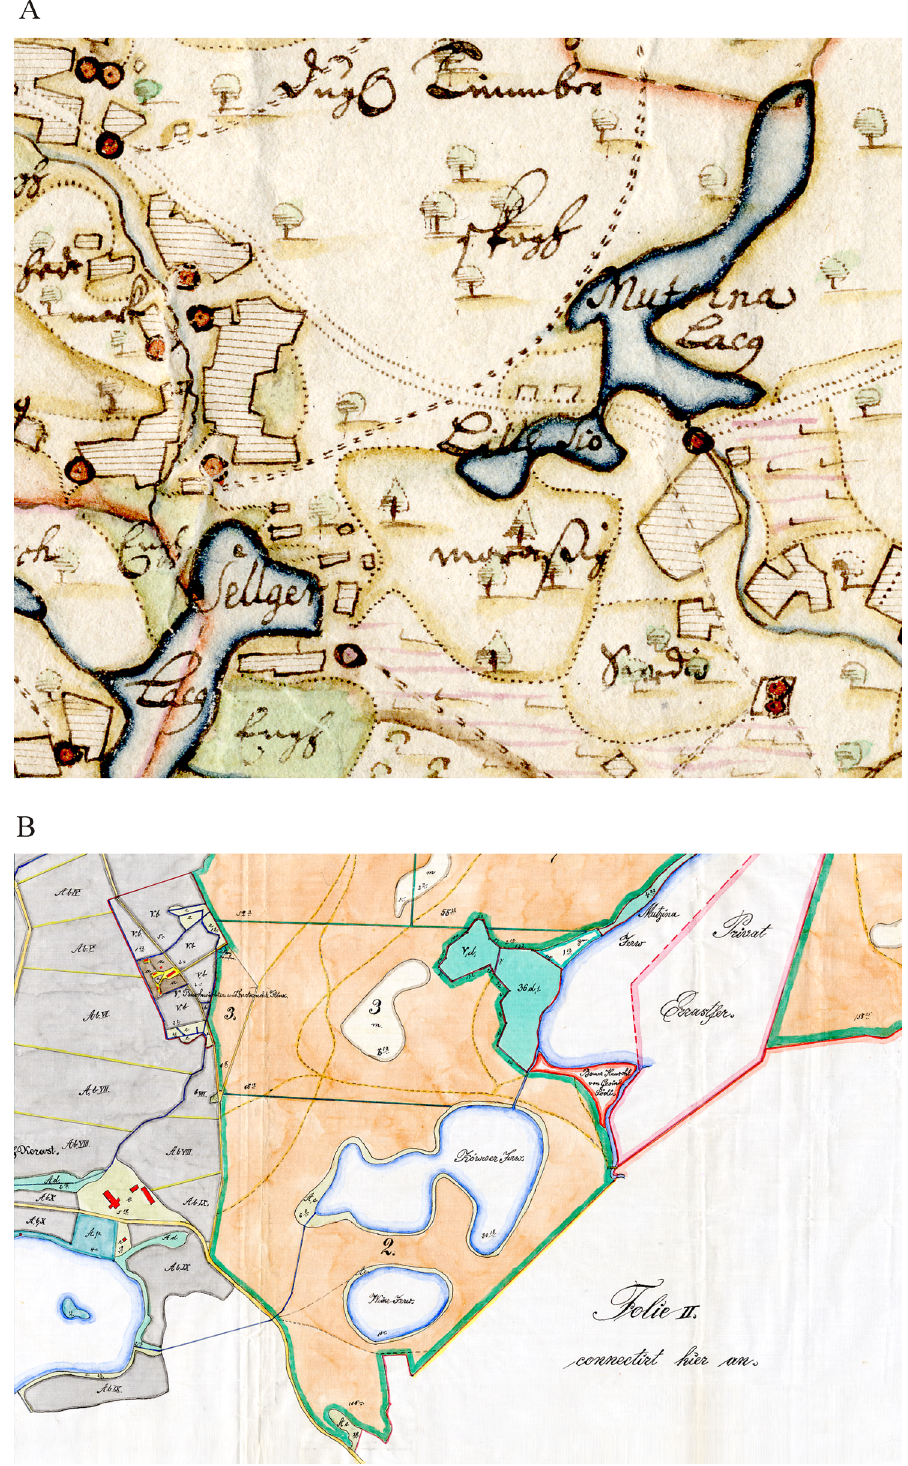
Fig. 5. Historical maps of Lake Kooraste Kıverj(cid:228)rv and its surroundings from the Estonian Historical Archives. A , the map of parishes from AD 1685, a connection between Lake Kooraste Kıverj(cid:228)rv and Lake Mutsina is seen. B , the plan of Karste Manor from AD 1903 shows that lakes Kooraste Kıverj(cid:228)rv, Suurj(cid:228)rv and Mutsina are all connected by